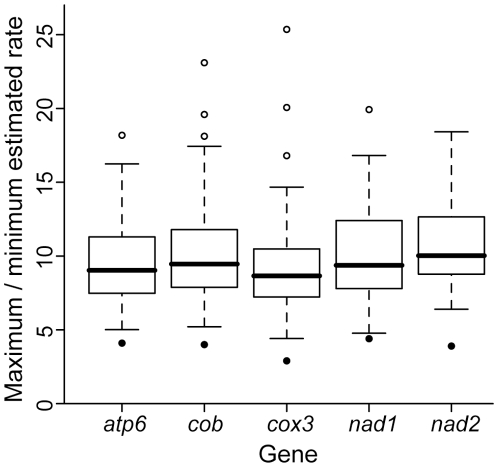
Rate variation observed for datasets simulated on 27-taxon trees and analyzed in a Bayesian framework.Data were simulated with a molecular clock model using the model and model parameters estimated for five mitochondrial genes for plethodontid salamanders [21] (boxes). For comparison, rate variation observed for empirical data from plethodontid salamanders from Mueller [21] is also shown (filled circles).